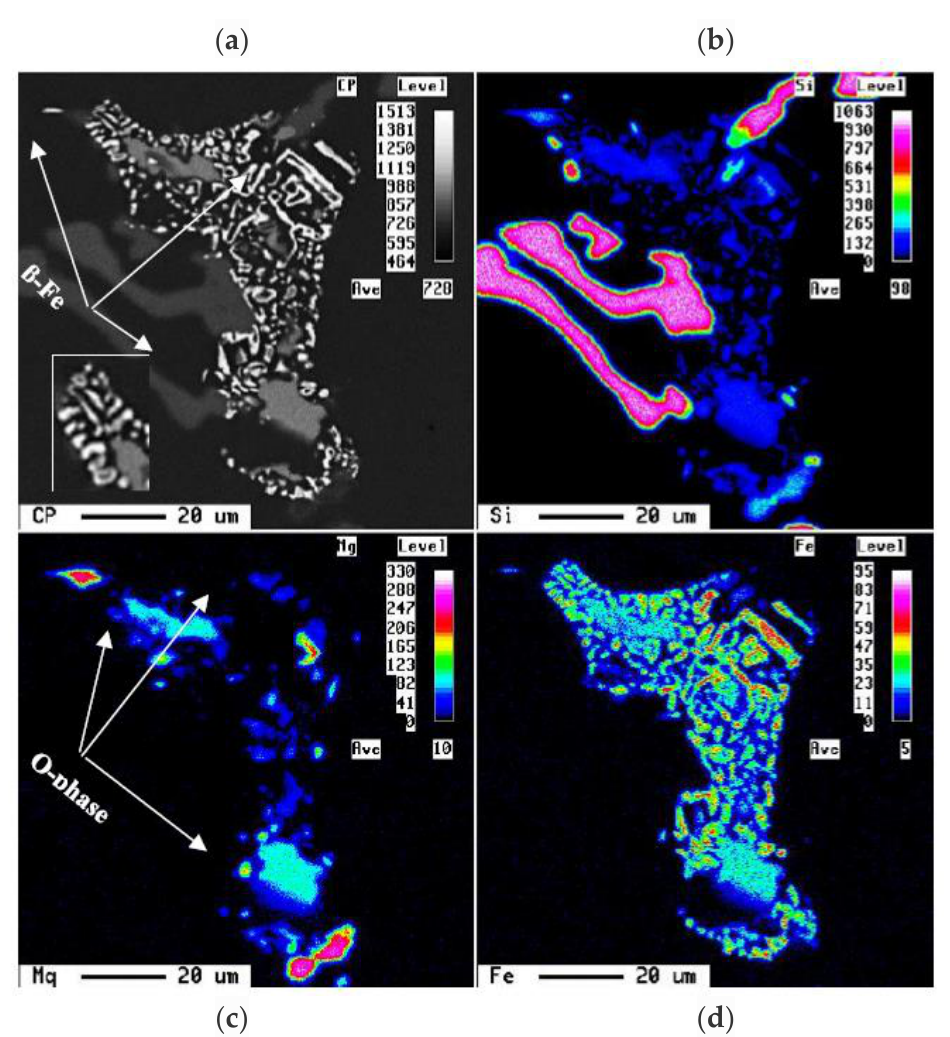
Figure 10. ( a ) Backscattered electron image sectioned from an alloy C sample (0.35 °C/s), and corresponding X-ray maps of ( b ) Si, ( c ) Mg, and ( d ) Fe elements in ( a ). The inset in ( a ) shows the decomposition of π - Fe to β -Fe (white arrows) following solution heat treatment [39].